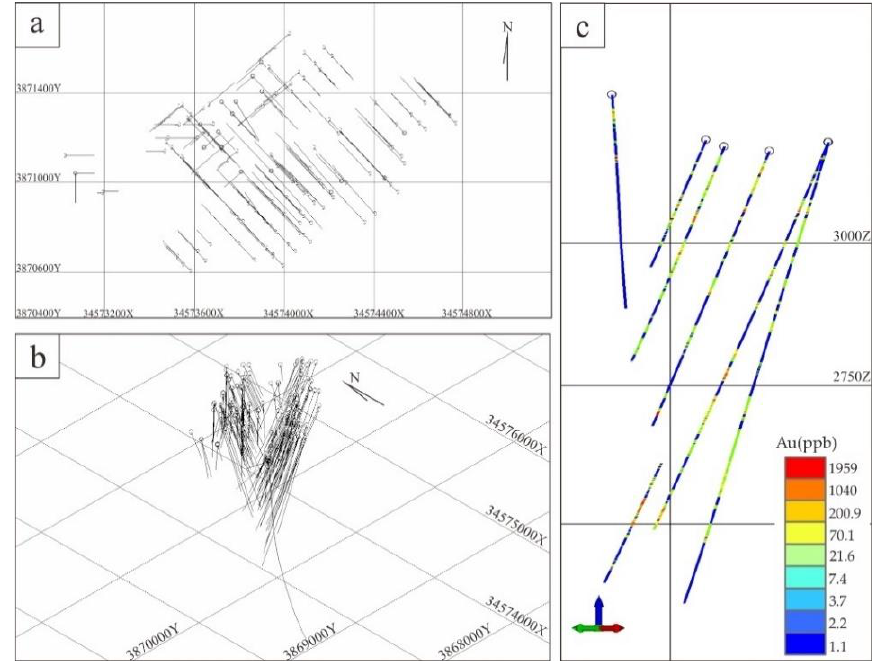
Figure 3. 3D model of Drillings in Zaozigou gold deposit. ( a ) Plan view of drillings distribution. ( b ) Side view of drillings distribution. ( c ) Sample grade distribution of drillings.